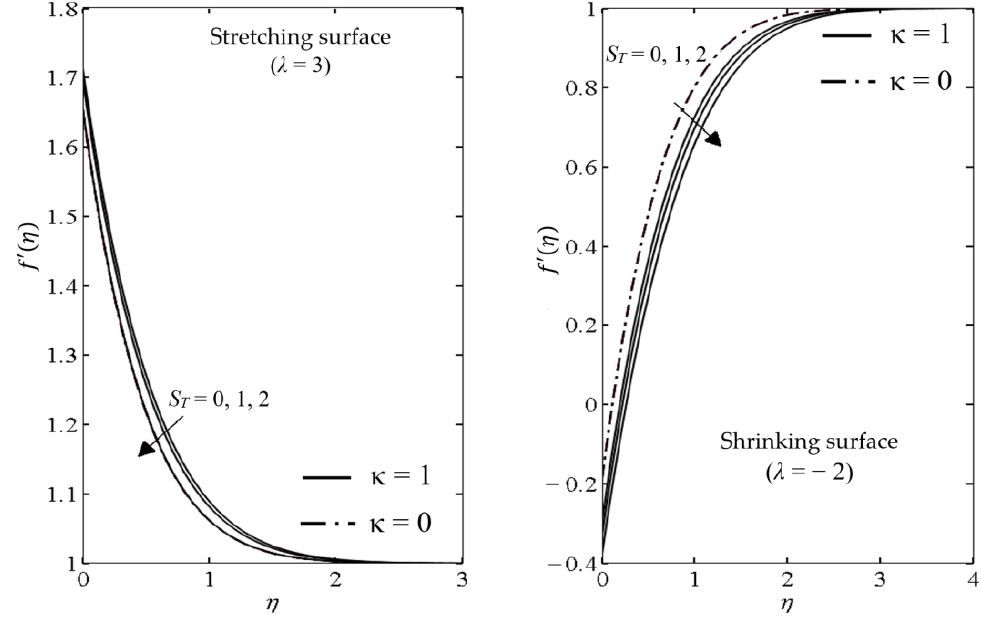
Figure 8. Influence of the Soret effect parameter, S T , on the velocity profiles for different parameters